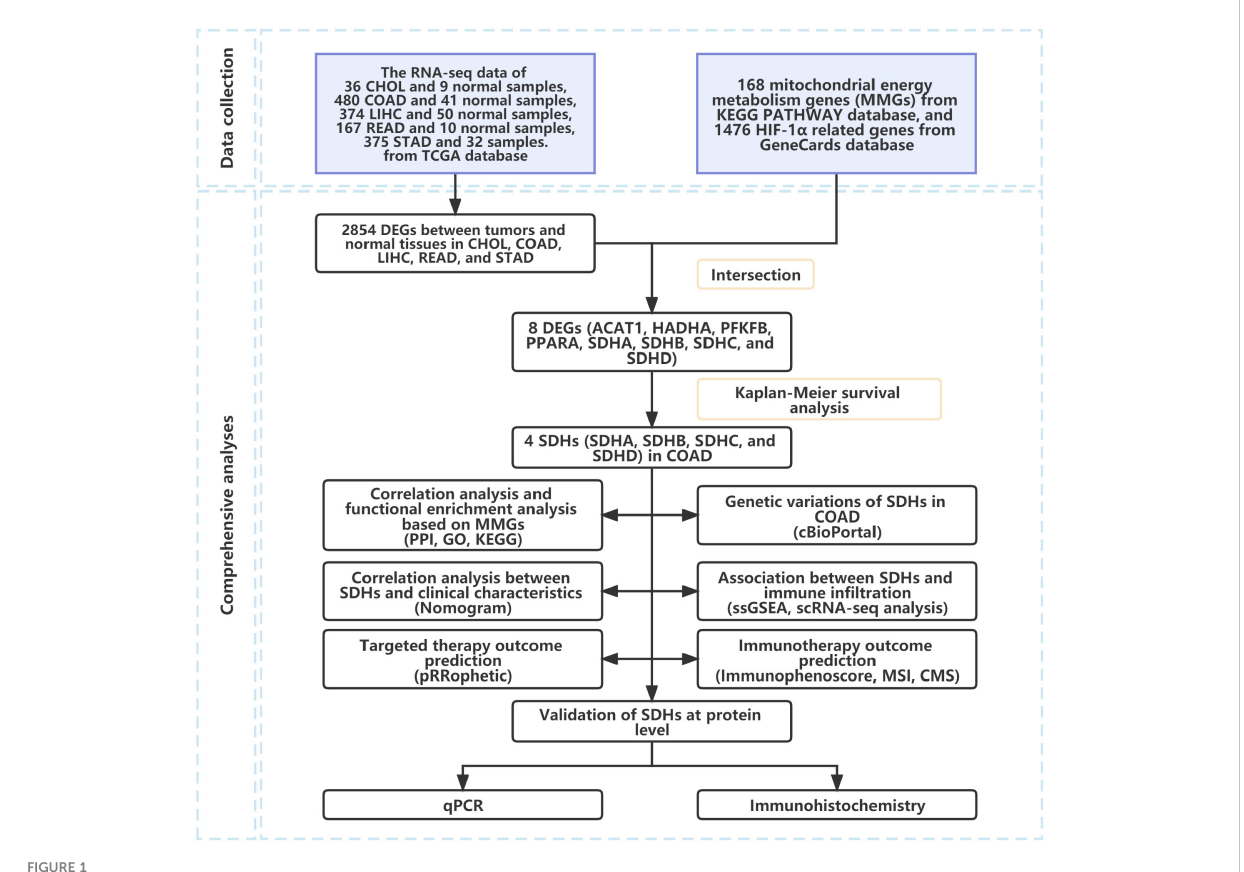
FIGURE 1 Flowchart of the study